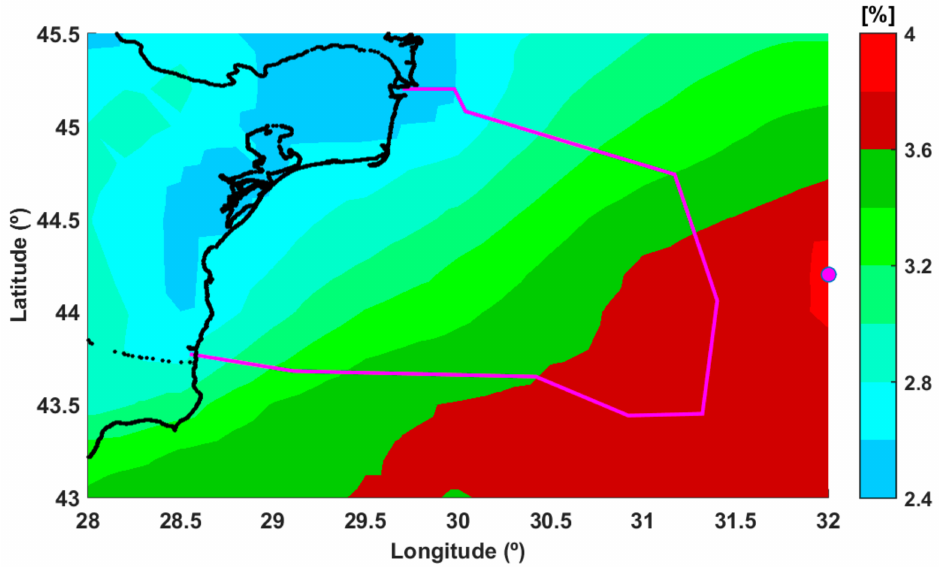
Figure 8. Interannual variability ( IAV ) of U 100 from ERA5, where the Romanian EEZ is indicated by the magenta